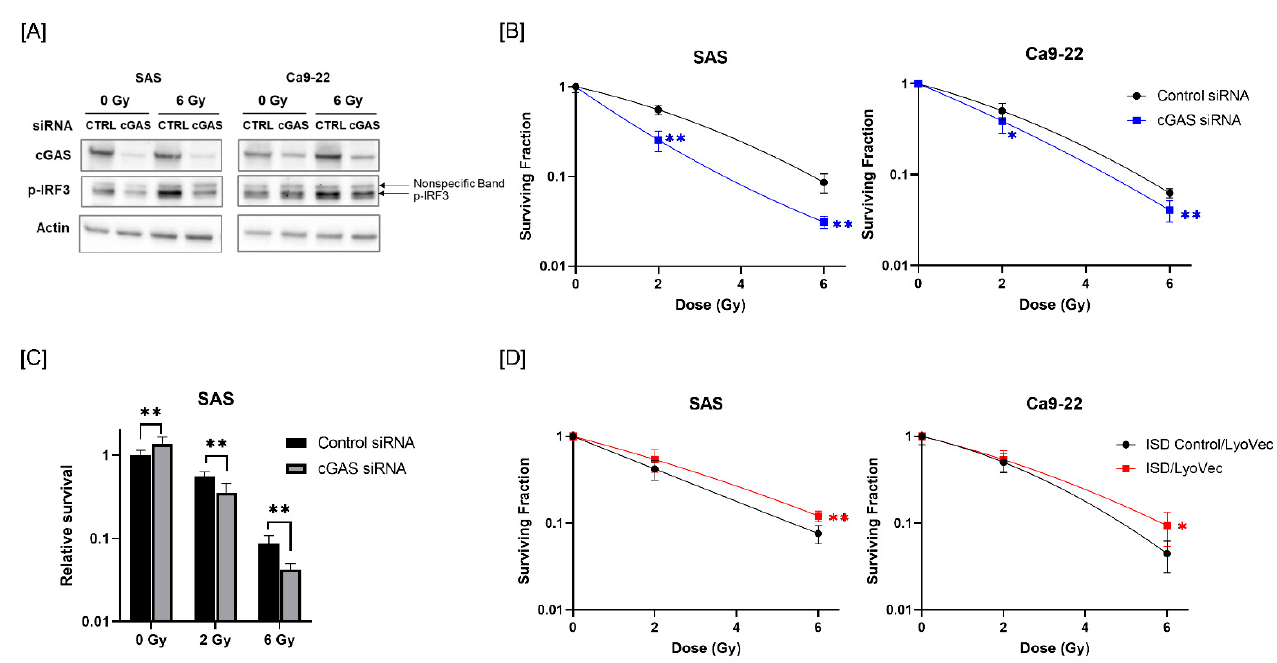
Figure 2. Effect of cGAS knockdown and agonist on the radiosensitivity of HNSCC cells. ( A ) HNSCC cells (SAS and Ca9-22) transfected with the control or cGAS siRNA were harvested and irradiated with 6 Gy X-rays. After 24 h (SAS) or 48 h (Ca9-22) of culture, the cells were harvested for western blot analysis. A representative image of an immunoblot is shown. Actin was used as the loading control. p-IRF3 indicates phosphorylated-IRF3. ( B ) cGAS knockdown HNSCC cells were irradiated with X-rays. After about 24 h of culture, the cells were harvested and seeded for colony formation assays. The results are shown as the surviving fraction of HNSCC cells. ( C ) Relative survival of SAS cells compared with non-irradiated cells transfected with control siRNA. ( D ) HNSCC cells treated with ISD Control/LyoVec TM or ISD/LyoVec TM for 24 h were irradiated with X-rays, and further cultured for 24 h. After culturing, the cells were harvested and seeded for colony formation assays. Results are shown as the surviving fraction of irradiated cells. * and ** indicate p < 0.05 and p < 0.01, respectively.